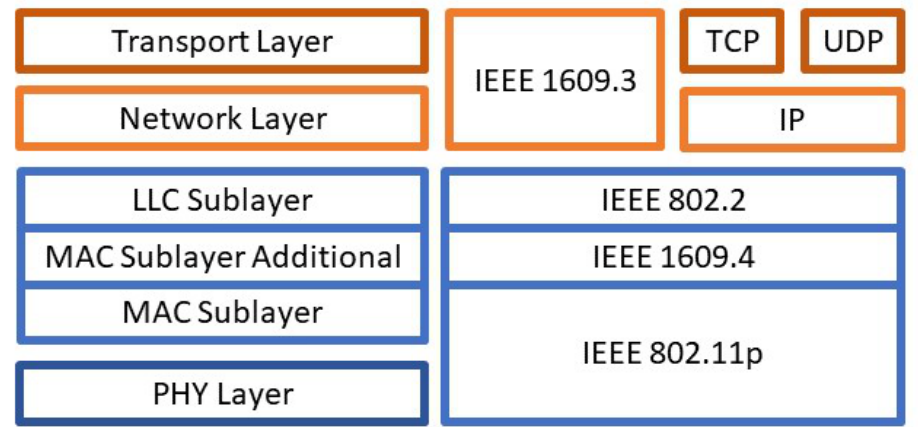
Figure 3. Visual representation of DSRC layers and protocols taken from